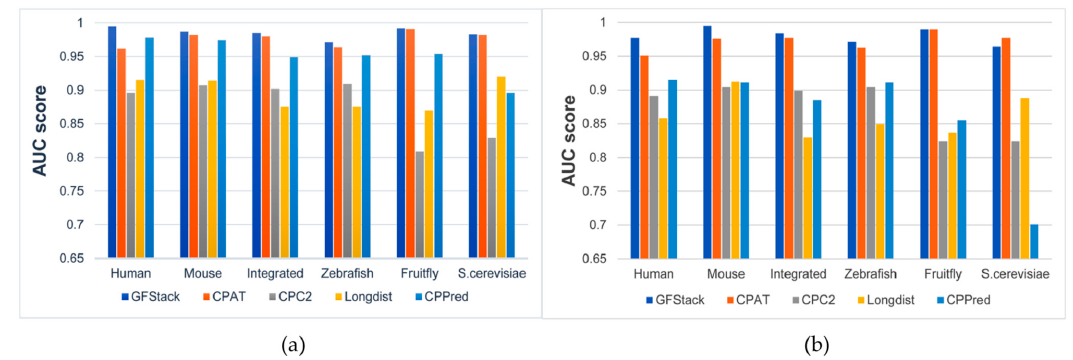
Figure 4. The performances (AUC scores) of all models in cross-species prediction. ( a ) The results of all models trained on Human-Main. ( b )The results of all models trained on Mouse-Main.